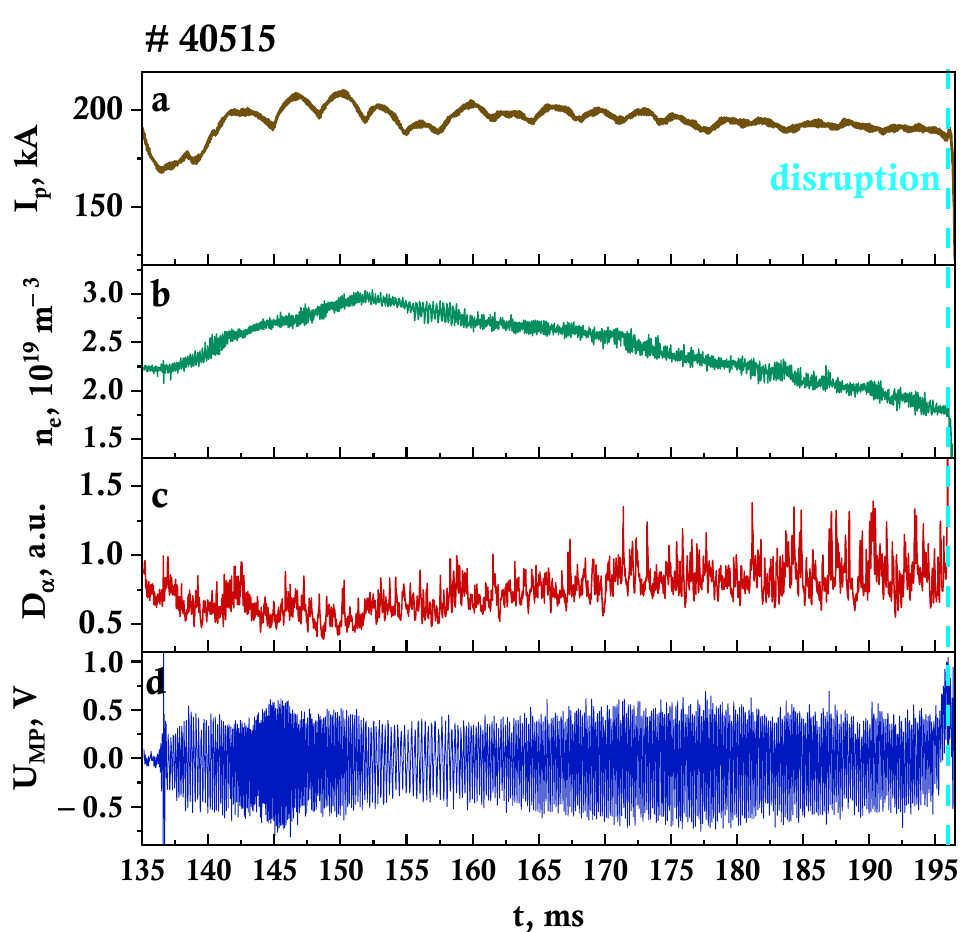
Figure 5. The Globus-M2 plasma parameters for discharge #40515: ( a ) plasma current I p , ( b ) electron density n e , ( c ) D α signal, ( d ) magnetic probe signal U MP .